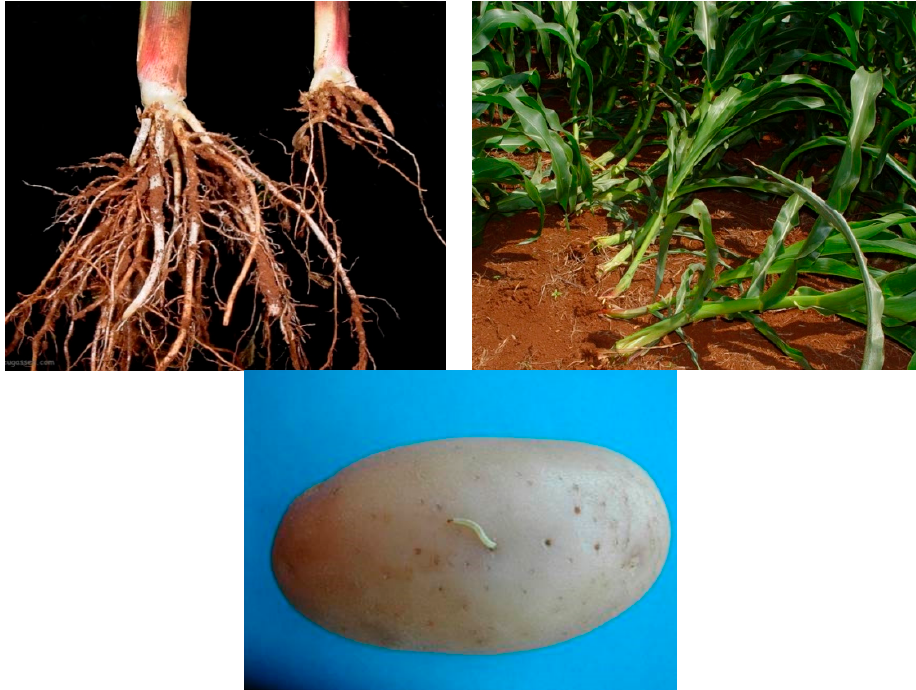
Figure 4. Top, typical damage on maize roots and lodging caused by D. speciosa and D. viridula larvae. (photos by Dirceu N. Gassen); below, D. speciosa larva on potato with typical pinprick damage (photo by Pablo Lanzetta).